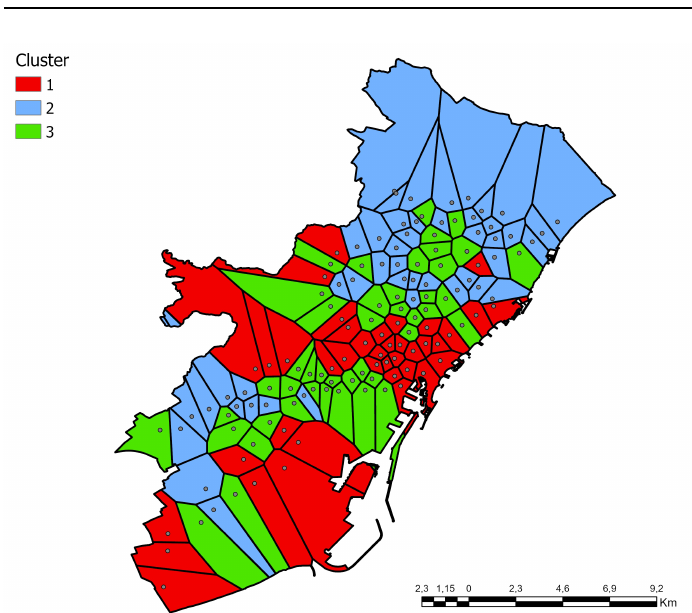
Figure 11. Map of stations coloured by the cluster they belong